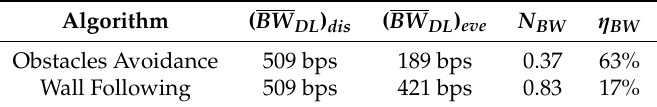
Table 4. Bandwidth